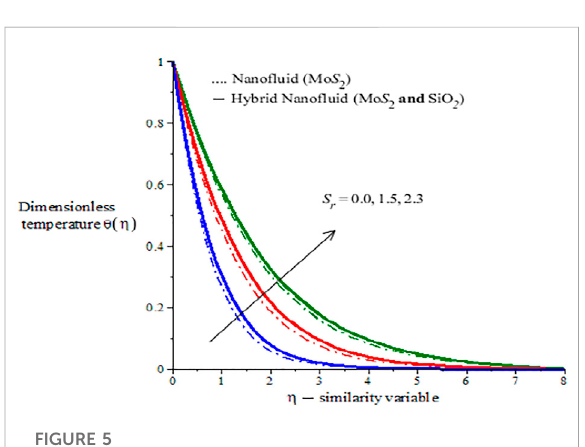
FIGURE 8 Variation in concentration curves versus S r .